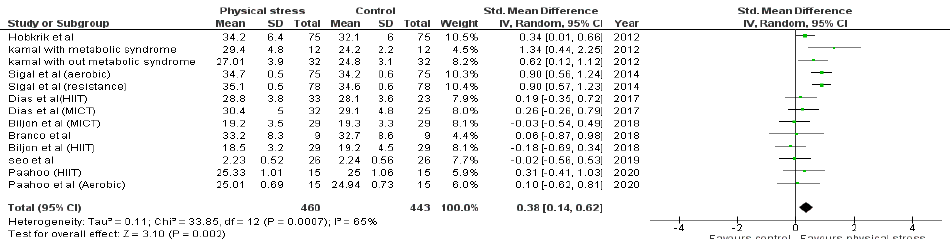
Figure 3. Forest plot showing the results for BMI. Figure 4. Forest plot showing the results for DBP.